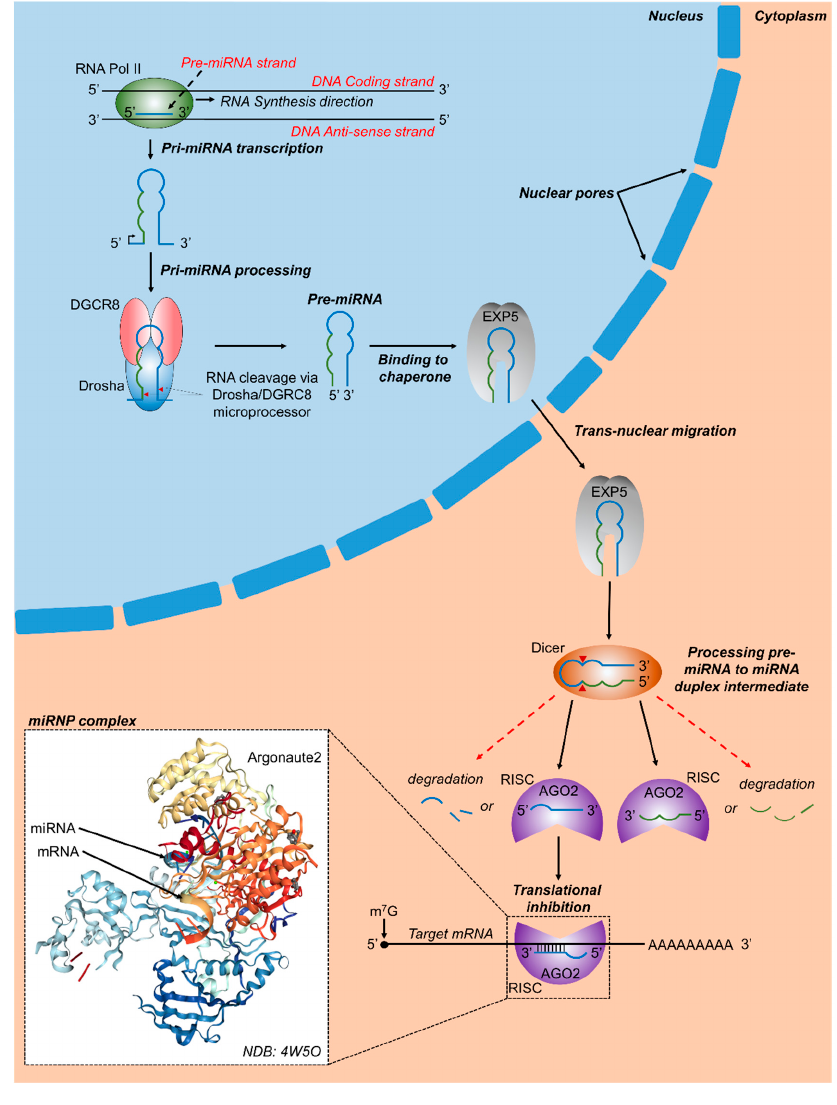
Figure 1. Canonical microRNA biogenesis and RNA targeting. In vertebrates, RNA polymerase-II transcribes primary miRNA genes (pri-miRNAs), which contain a hairpin-loop along with 5 ′ and 3 ′ flanking regions. DGCR8 (DiGeorge critical region 8) and a Drosha molecule combine to form the microprocessor complex which binds with pri-miRNA and cleaves it at specific sites (red arrowheads). The resulting precursor miRNA (pre-miRNA) contains a phosphate on its 5 ′ end and a hydroxyl group on its 3 ′ end along with a 2 to 3 nucleotide over-hang. Subsequently, the nuclear chaperone Exportin 5 (EXP5) binds to pre-miRNA molecules and transports pre-miRNA molecules to the cytoplasm via transnuclear migration, where Dicer, another RNAse III enzyme, binds to pre-miRNA molecules, cleaves them at specific regions, and releases a miRNA duplex intermediate. Argonaute 2 (AGO2) and other proteins assemble with miRNA molecules released from the miRNA duplex intermediate, together forming the RNA induced silencing complex (RISC). The 3 ′ or 5 ′ miRNA containing RISCs may bind to target regions and either result in translational repression, mRNA degradation, or in some cases translational activation. Inset shows a crystal structure of human Argonaute 2 bound to a guide and target RNA